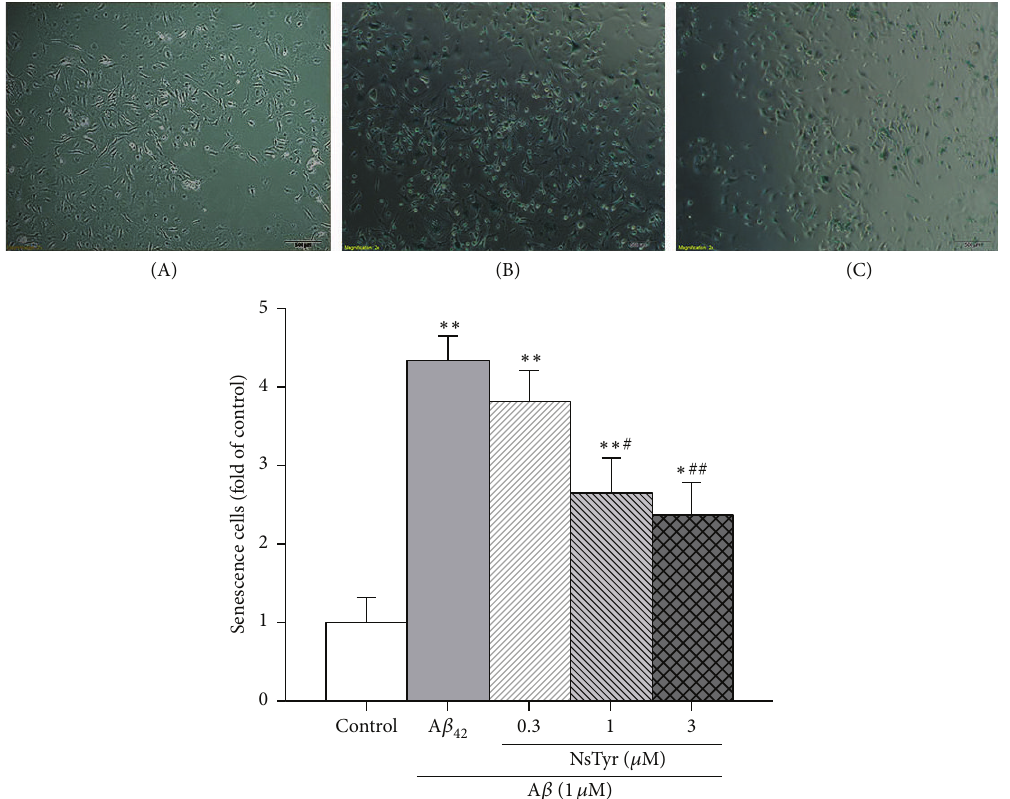
Figure 7: The effects of NsTyr-2K on the numbers of SA- 𝛽 -gal positive cells of NSPCs after A 𝛽 1 insult + NsTyr-2K. Quantification by densitometric scanning was presented below. The error bars represent the standard error and (C) A 𝛽 1 – 42 of the mean (S.E.M.) of at least three experiments ( 𝑛 = 3 ). ∗ 𝑃 < 0.05 , ∗∗ 𝑃 < 0.01 versus control group. # 𝑃 < 0.05 , ## 𝑃 < 0.01 versus A 𝛽 1